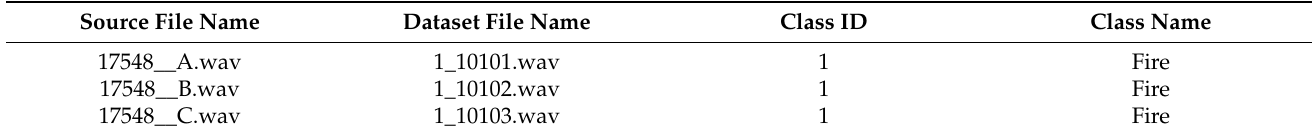
Table 3. Sample of metadata of the FSC22 dataset.